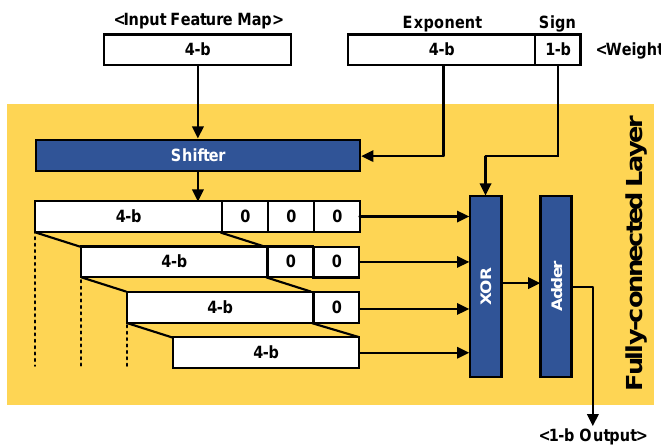
Figure 9. Block diagram of the fully connected layer. Table 1. Performance summary of the proposed CIS.